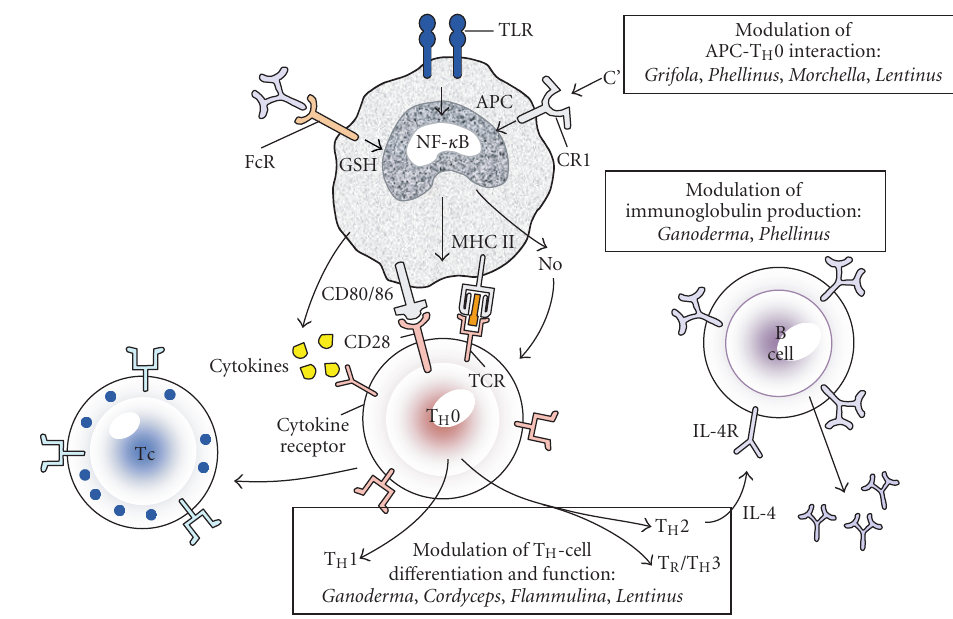
Figure 3. Schematic representation of the possible targets of the adaptive immune system for mushroom ingredients with im- munomodulatory properties. APC: antigen-presenting cell; FcR: Fc receptor; TLR: Toll-like receptor; CR1: complement receptor type 1; C’: activated complement; GSH: glutathione; MHC II: major histocompatibility complex class II; TCR: T-cell receptor; T H : helper T cells; T C : cytotoxic T lymphocytes; T R : regulatory T cells; NO: nitric oxide; IL-4: interleukin-4; IL-4R: interleukin-4 receptor; CD: cluster